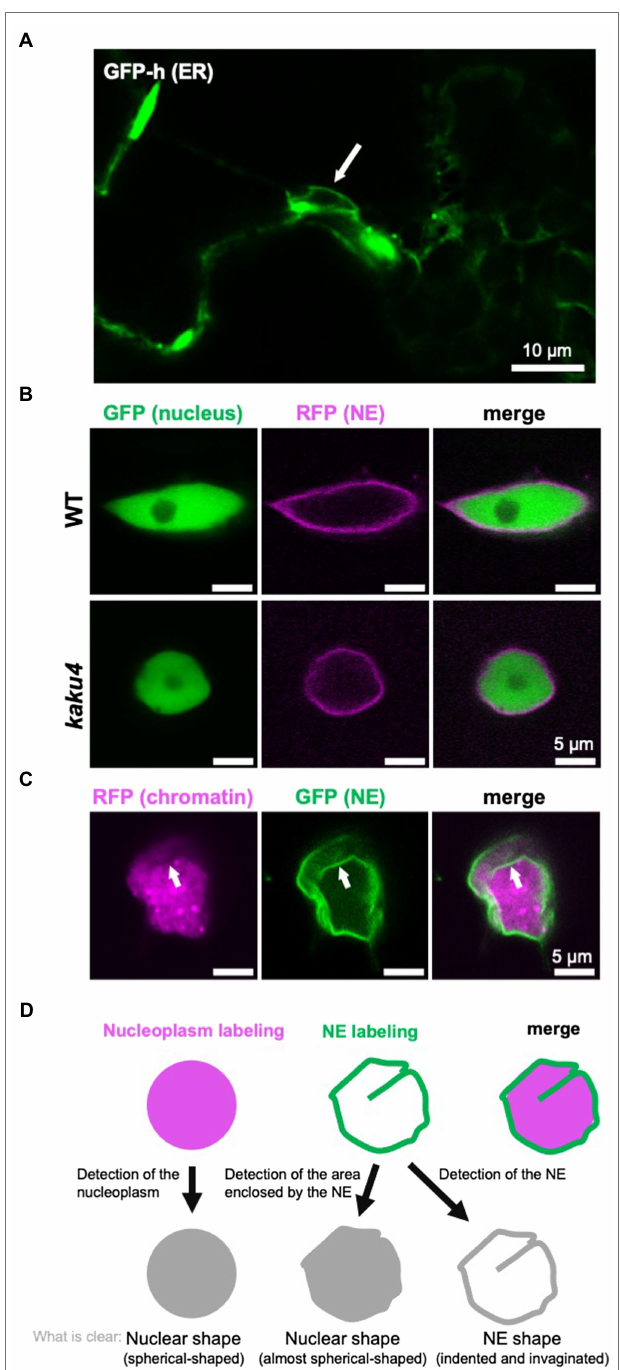
FIGURE 2 | Detection and definition of the nuclear shape and the NE shape. (A) A confocal microscope image of A. thaliana cotyledon epidermal cells of 7-day-old GFP-h (Mitsuhashi et al., 2000; Hayashi et al., 2001; Nakano et al., 2009), in which ER is fluorescently labeled by GFP. The NE, contiguous with ER, is also visualized. The white arrow indicates a nucleus. (B) Confocal images of A. thaliana WT and kaku4 root cells stably coexpressing Nup50a- GFP (Tamura et al., 2010, 2013; Goto et al., 2014) and SUN2-TagRFP (Tamura et al., 2013), each under the control of the 35S promoter. The nucleus, except for the nucleolus, is fluorescently visualized by